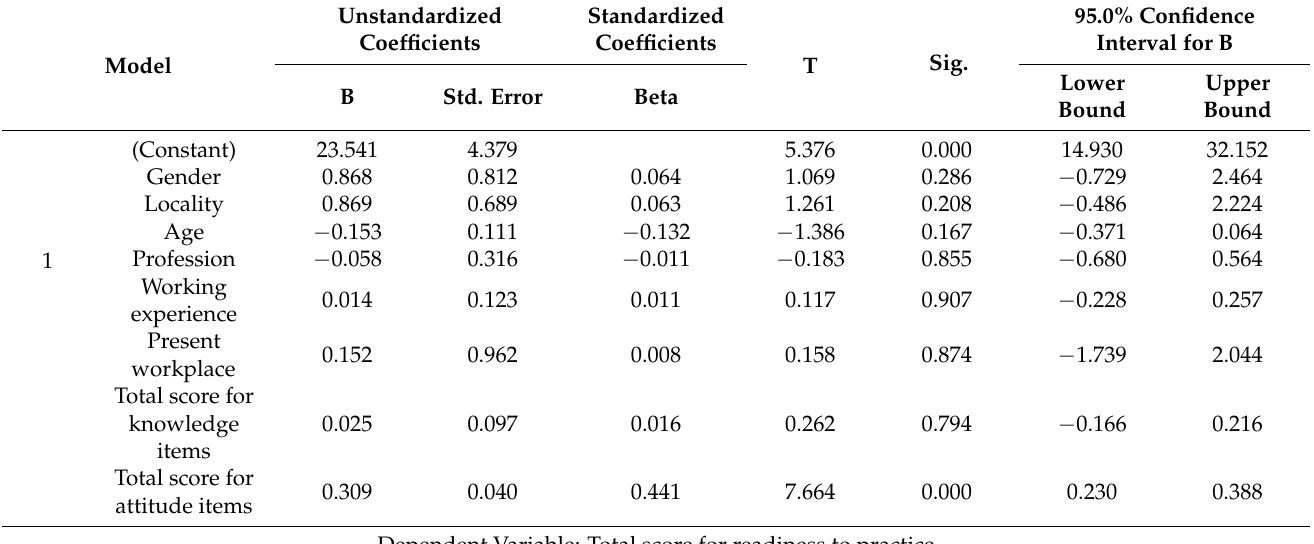
Table 6. Predictors of readiness to